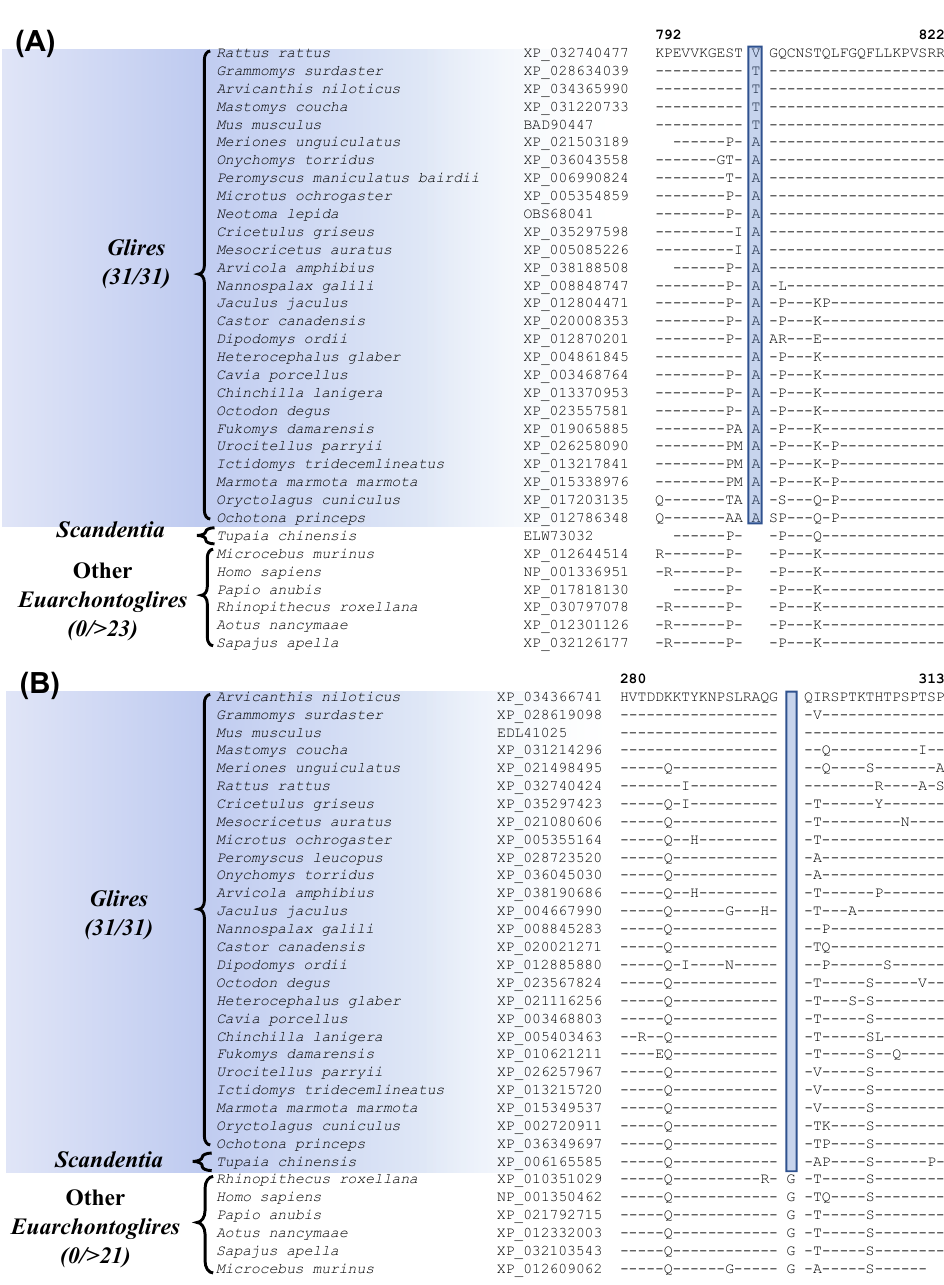
Figure 2. Partial sequence alignments of ( A ) junctional protein associated with coronary artery disease, containing a 1 aa insertion that is specific for the Glires; and ( B ) adenylyl cyclase-associated protein 2 containing a 1 amino acid deletion that is uniquely shared by the Glires and Tupaia chinensis (Scandentia). The accession numbers of the sequences are shown in the second column and the dashes (–) in the alignments indicate sequence identity with the amino acid present in the top